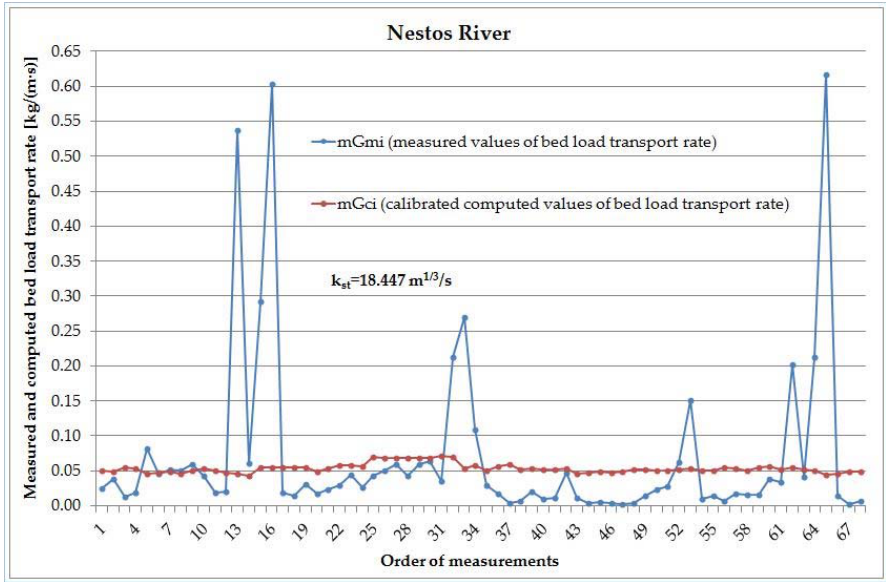
Figure 1. Measured and calibrated computed values of bed load transport rate of Nestos